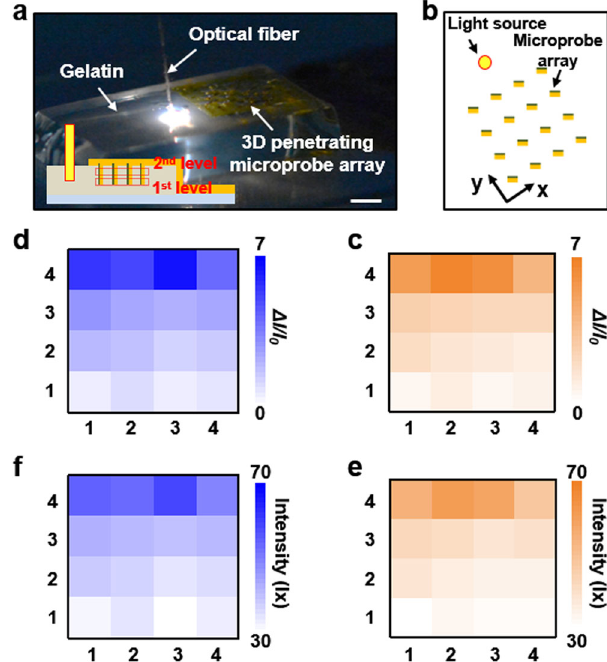
Fig. 5 Demonstration of the light intensity mapping. a Optical image of the experimental setup. The inset is the schematic front view of the setup. (scale bar, 5 mm) b Schematic top view of the injected light source and microprobe array. c , d The photocurrent maps from the fi rst level c and the second level d of photodetectors on the microprobes. e , f The light intensity maps from the photodetectors at the fi rst level and the second level,